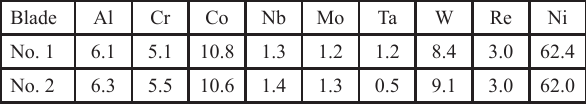
Table 1. Summary of the chemical composition analysis, SEM-EDX for blades No. 1 and No. 2, (% of weight)